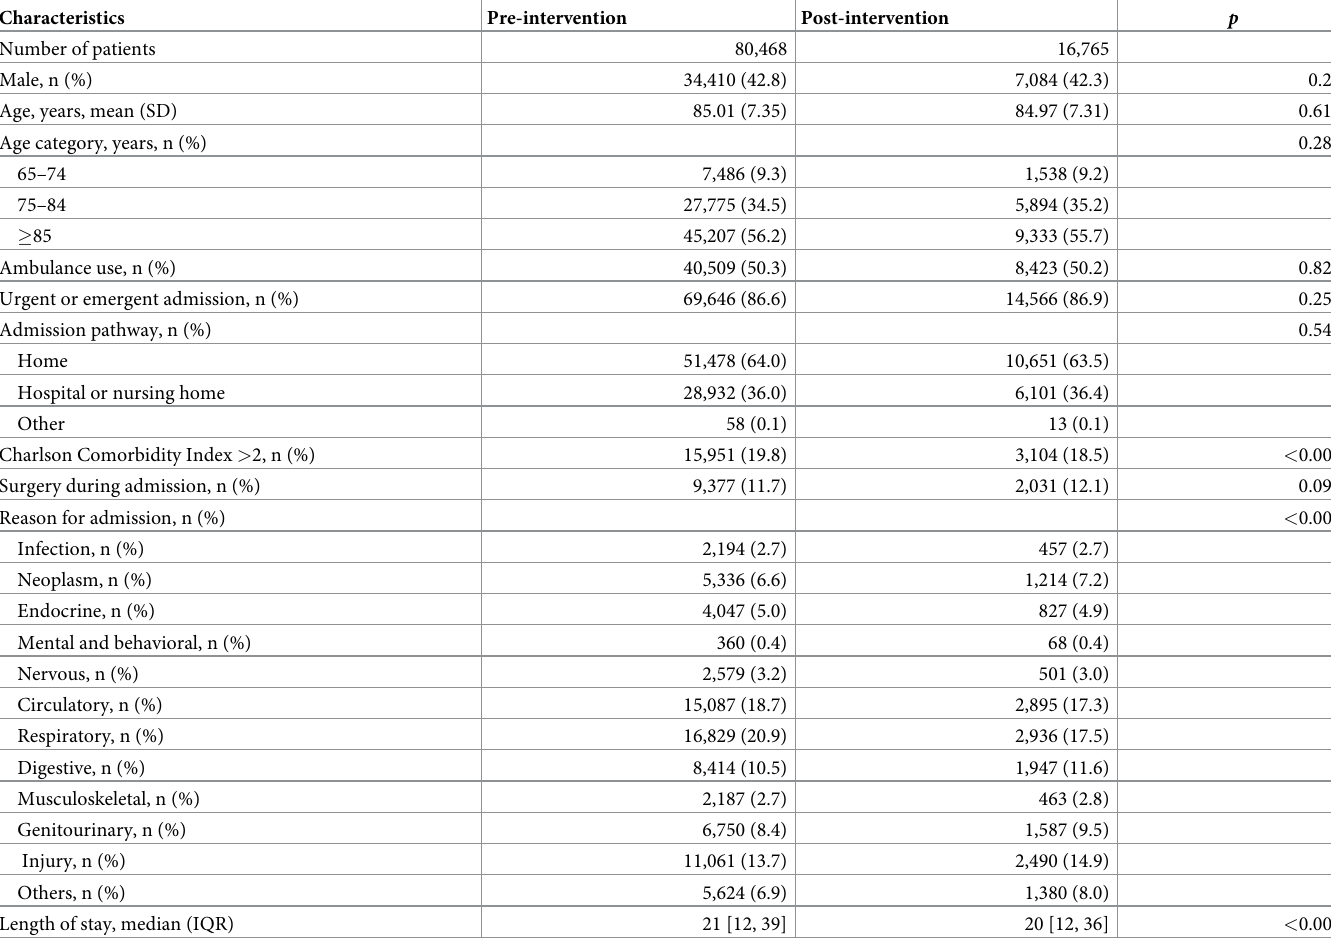
Table 1. Characteristics of patients who received dementia care before and after COVID-19-related regulatory changes in hospitals that received COVID-19-posi- tive patients.